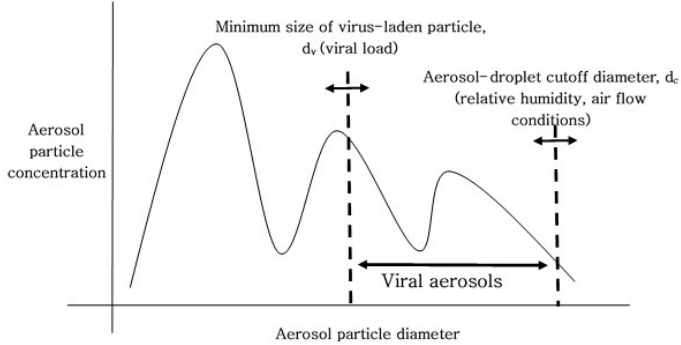
Figure 1. Size distribution of emitted respiratory particles. Generation of viral aerosols is determined by the minimum size of respiratory particles carrying viruses (d v , decided by a viral load) and the aerosol–droplet cutoff particle diameter (d c , which depends on the relative humidity and air flow conditions). 2. Four Universal Conditions Required for the Rapid Spread of Respiratory Viruses, Including SARS-CoV-2 and Its Variants (the Alpha VOC and the Delta VOC), and the Effect of Vaccination on Viral Aerosol Generation In the coronavirus disease (COVID-19) pandemic, questions are arising regarding the underlying mechanisms responsible for the rapid spread of severe acute respiratory syndrome coronavirus 2 (SARS-CoV-2) and its variants such as the Alpha variant of concern (VOC) (formerly known as B.1.1.7) and the Delta VOC (formerly known as B.1.617.2). This study introduces the universal principles that explain the rapid spread of respiratory viruses. These principles apply to all contagious diseases caused by respira- tory viruses. There are four fundamental conditions that need to be satisfied for the rapid spread of respiratory viruses. The first is asymptomatic hosts with viral shedding that peaks during the early stage of infection. Symptomatic hosts (with fever, fatigue, and cough) have limited contact with other people because of self-recognition of infection. However, asymptomatic hosts interact with other people freely, and viruses can easily move from asymptomatic hosts to non-infected individuals. The second is massive shedding of the virus from the infected cells of hosts in their respiratory fluids, which is a high viral load condition. Small respiratory particles have a greater chance of carrying viruses (small virus-laden particles) under high viral load conditions than under low viral load condi- tions. Thus, viral aerosols can be generated from small virus-laden respiratory particles under high viral load conditions and spread in the nearby environment. The third is the stability of respiratory viruses in the outside air. For long distance transmission over a long period, the stability of airborne viruses is crucial. The fourth is a strong binding af- finity of viruses to human cells at the receptors of entry points such as the nose, mouth, and eyes. The fundamental conditions can even facilitate each other, for example, if a virus has an extremely strong binding affinity to human cells, it can compensate for lower concentrations of the virus in the air under low viral load conditions. These four fundamental conditions are universal requirements for the rapid spread of respiratory viruses. Concerning SARS-CoV-2, viral shedding by asymptomatic hosts has been reported to peak during the early stage of infection [5]. The viral load of SARS-CoV-2 in hosts reaches ~10 10 copies mL − 1 [6], which is significantly over the minimum viral load (~10 6 copies mL − 1 ) required for aerosol generation of respiratory viruses [4]. A study that in-